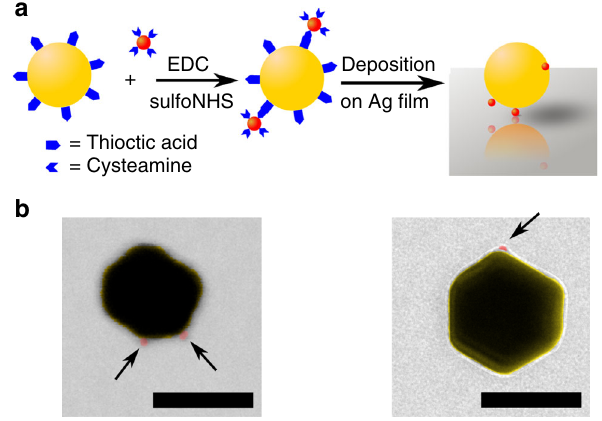
Fig. 2 Fabrication of coupled quantum-dot / gap-plasmon systems. a Illustration of the synthesis process. Quantum dots (red) are linked to gold nanoparticles (yellow) through their capping molecules. The linked assemblies are then deposited on a silver fi lm. b Electron-microscope images of linked assemblies. Quantum dots are colored in red and indicated by arrows. The left image was obtained by scanning transmission electron microscopy, and the right image was obtained by transmission electron microscopy. The scale bars are 100